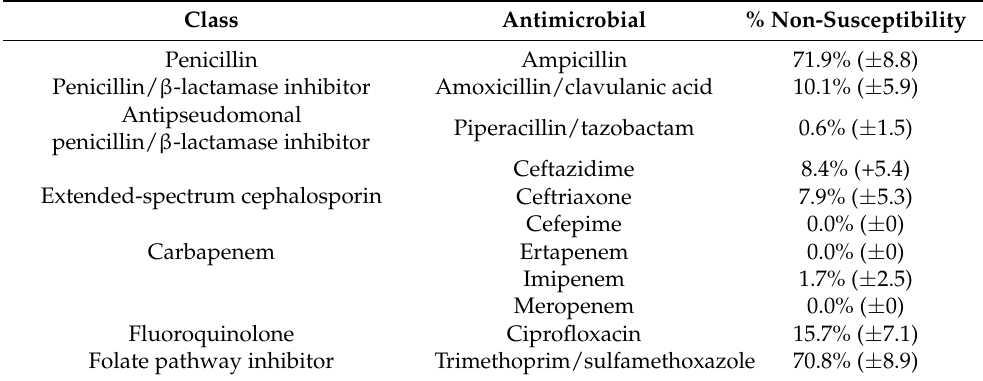
Table 2. Non-susceptibility levels of 178 S. enterica isolates against different antimicrobial agents.